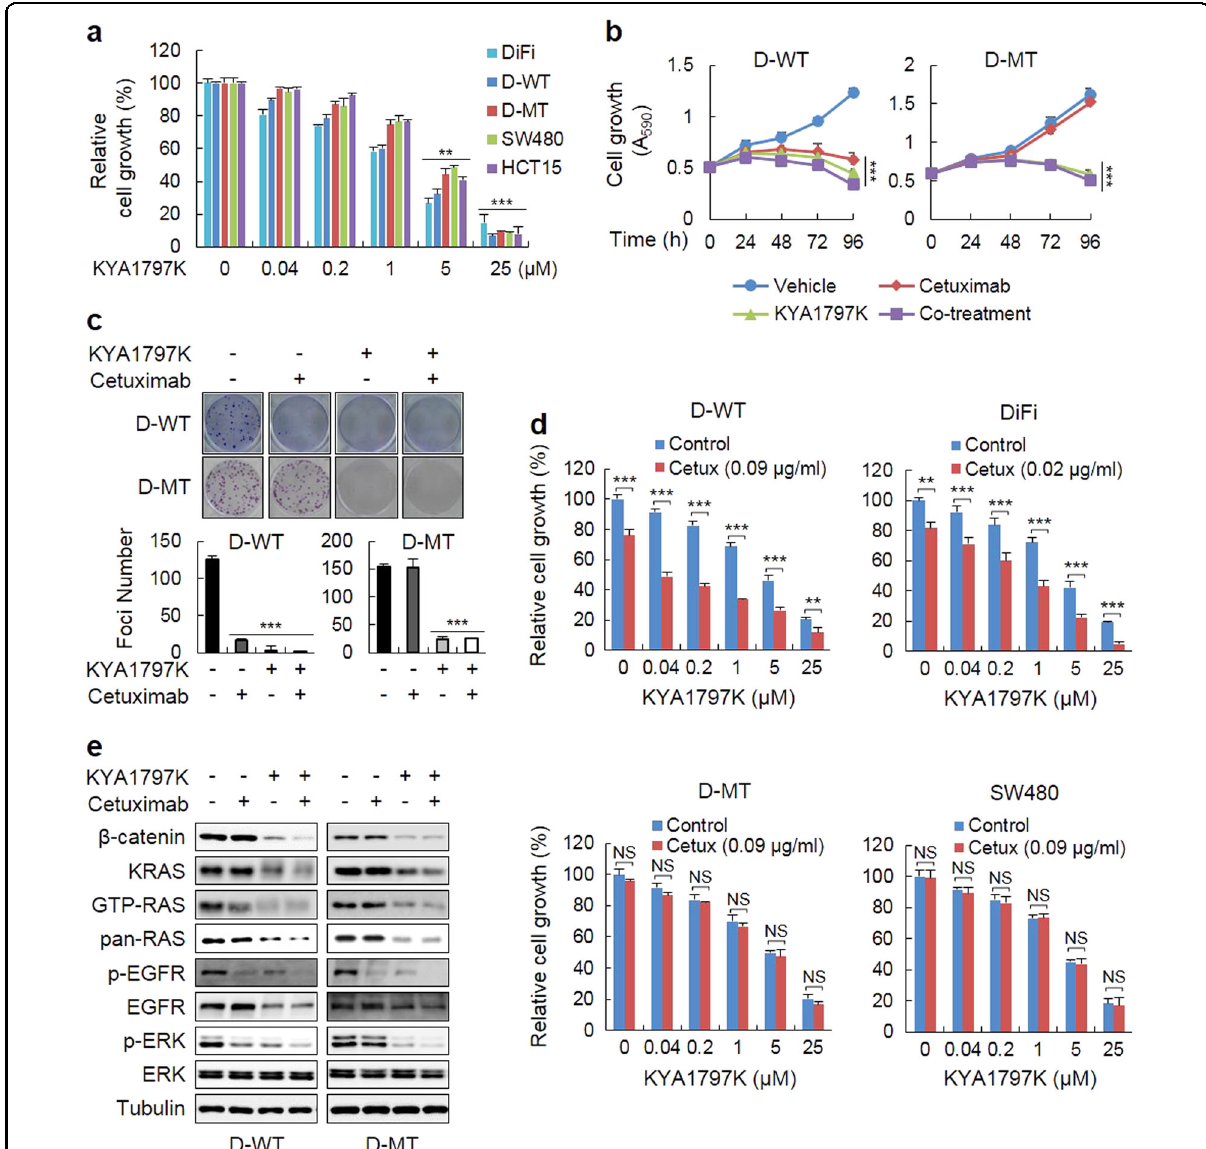
Fig. 3 KYA1797K overcomes the resistance to cetuximab attributed to KRAS mutations on the growth and transformation of CRC cells. a MTT assays were performed to determine the effects of KYA1797K on the growth of various CRC cells treated with the indicated doses of KYA1797K for 96 h. b , c The D-WT or D-MT cells were treated with vehicle, 25 µM KYA1797K, 5 µg/mL cetuximab, or were co-treated with both for the indicated time periods. The growth and transformation of the D-WT or D-MT cells were monitored by MTT ( b ) and foci formation ( c ) assays, respectively. d MTT assays were performed to determine the combined effect of KYA1797K and cetuximab in D-WT, DiFi, D-MT, and SW480 cells co-treated with the indicated doses of KYA1797K and cetuximab for 96 h. e IB analysis of D-WT or D-MT cells treated under the indicated conditions for 24 h. Glutathione- S-transferase (GST)-Raf-1 RAS-binding domain (RBD) pull-down assays were performed to detect active RAS (GTP-RAS). The data are presented as the mean ± SD ( n = 3). Two-sided Student ’ s t- test, ** P <0.005, and *** P <0.001. NS not signi fi